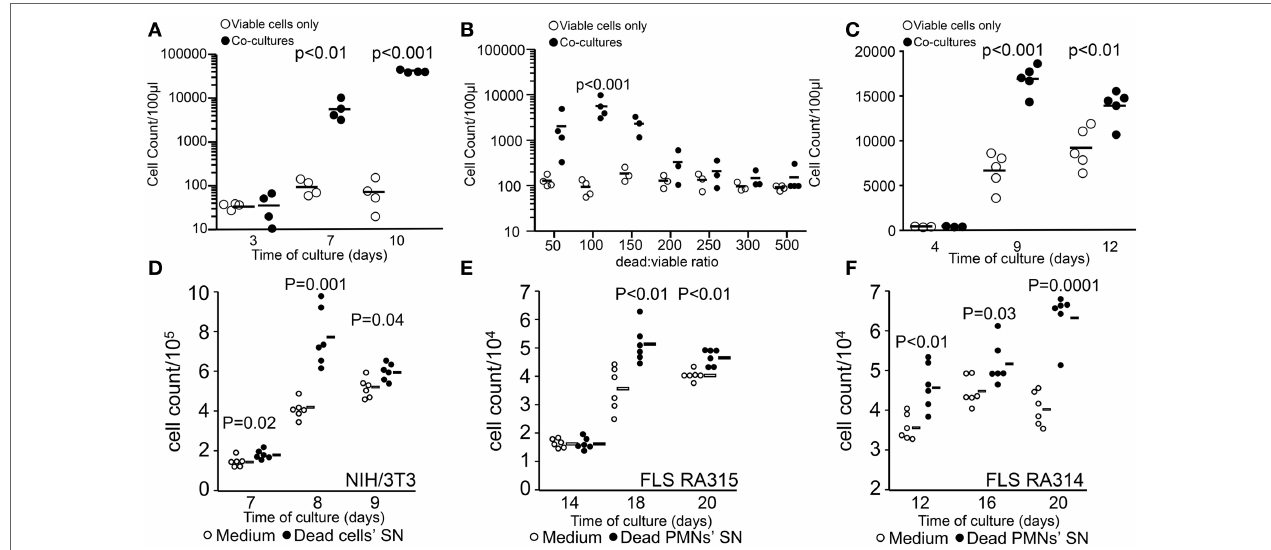
FigUre 1 | stimulation of tumor cell proliferation by bystander dying cells, the “feeder cells” effect . The upper panel shows viable cell counts of cocultures [closed circles in panels (a–c) ] and viable cells alone in D10 medium [open circles in panels (a–c) ]. Cocultures were composed of viable (200 cells/well) and lethally ultraviolet light type B-irradiated (10,000 cells/well) B16F10 melanoma cells (a) . Dead/viable ratio titration of cocultures (B) . Transwell cocultures with 10,000 apoptotic cells (c) . The lower panel shows cell counts of independent wells containing fibroblasts in R10 medium [open circles in panels (D–F) ] or in supernatants (SN) from apoptotic cells [closed circles in panels (D–F) ]. Mouse NIH/3T3 fibroblast (1,000 cells/well) cultures with SNs of 0.2 million cells/ml apoptotic homologous cells (D) . Human fibroblast-like synoviocytes (FLS, 1,000 cells/well) from two rheumatoid arthritis patients RA315 (e) and RA314 (F) cocultured with SNs from apoptotic neutrophils (0.2 million